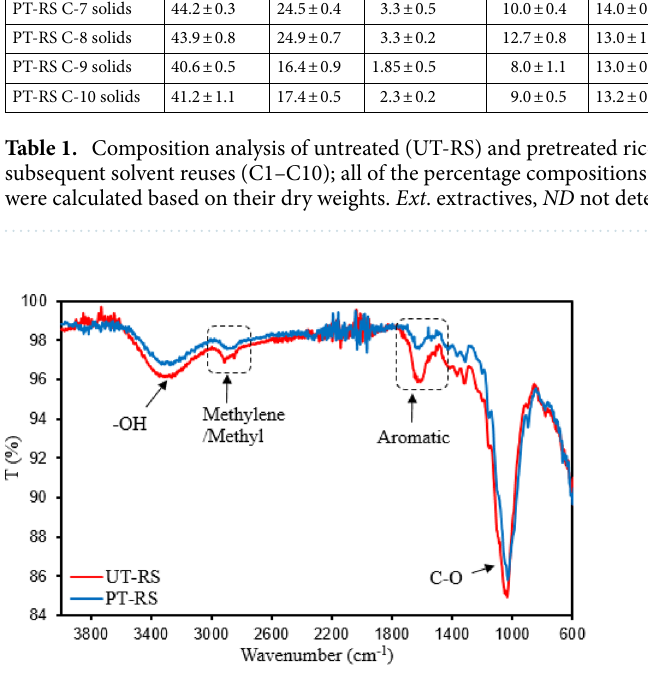
Figure 2. FTIR spectra of untreated (UT-RS) and DES-THF pretreated rice straw